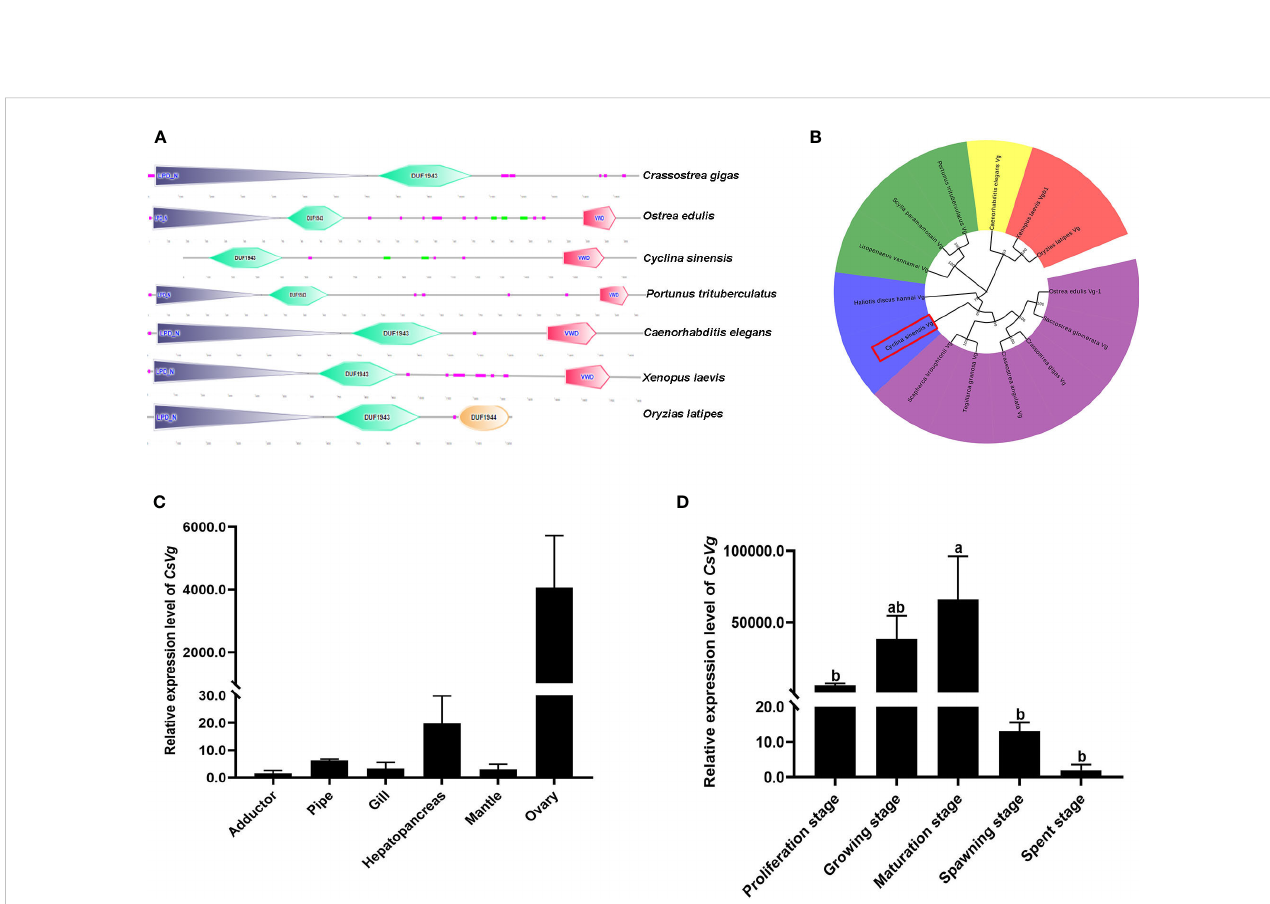
FIGURE 7 Sequence analysis of CsVg and its expression pro fi le in tissues of C sinensis . (A) Domain structures of CsVg and other selected species. (B) Phylogenetic tree based on amino acid sequences of Vg gene (C) Relative expression of CsVg in different tissues (D) Relative expression of CsVg in different ovarian development stages. The columns with different letter indicate signi fi cant difference ( P <